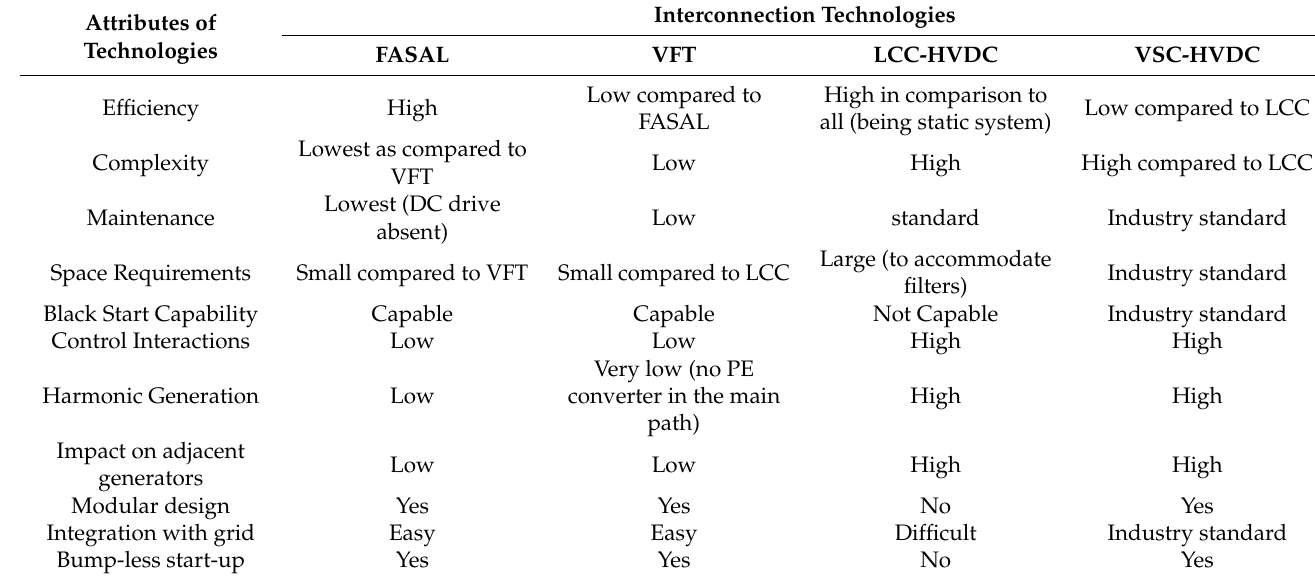
Table 5. Comparative analysis of various grid interconnection technologies.